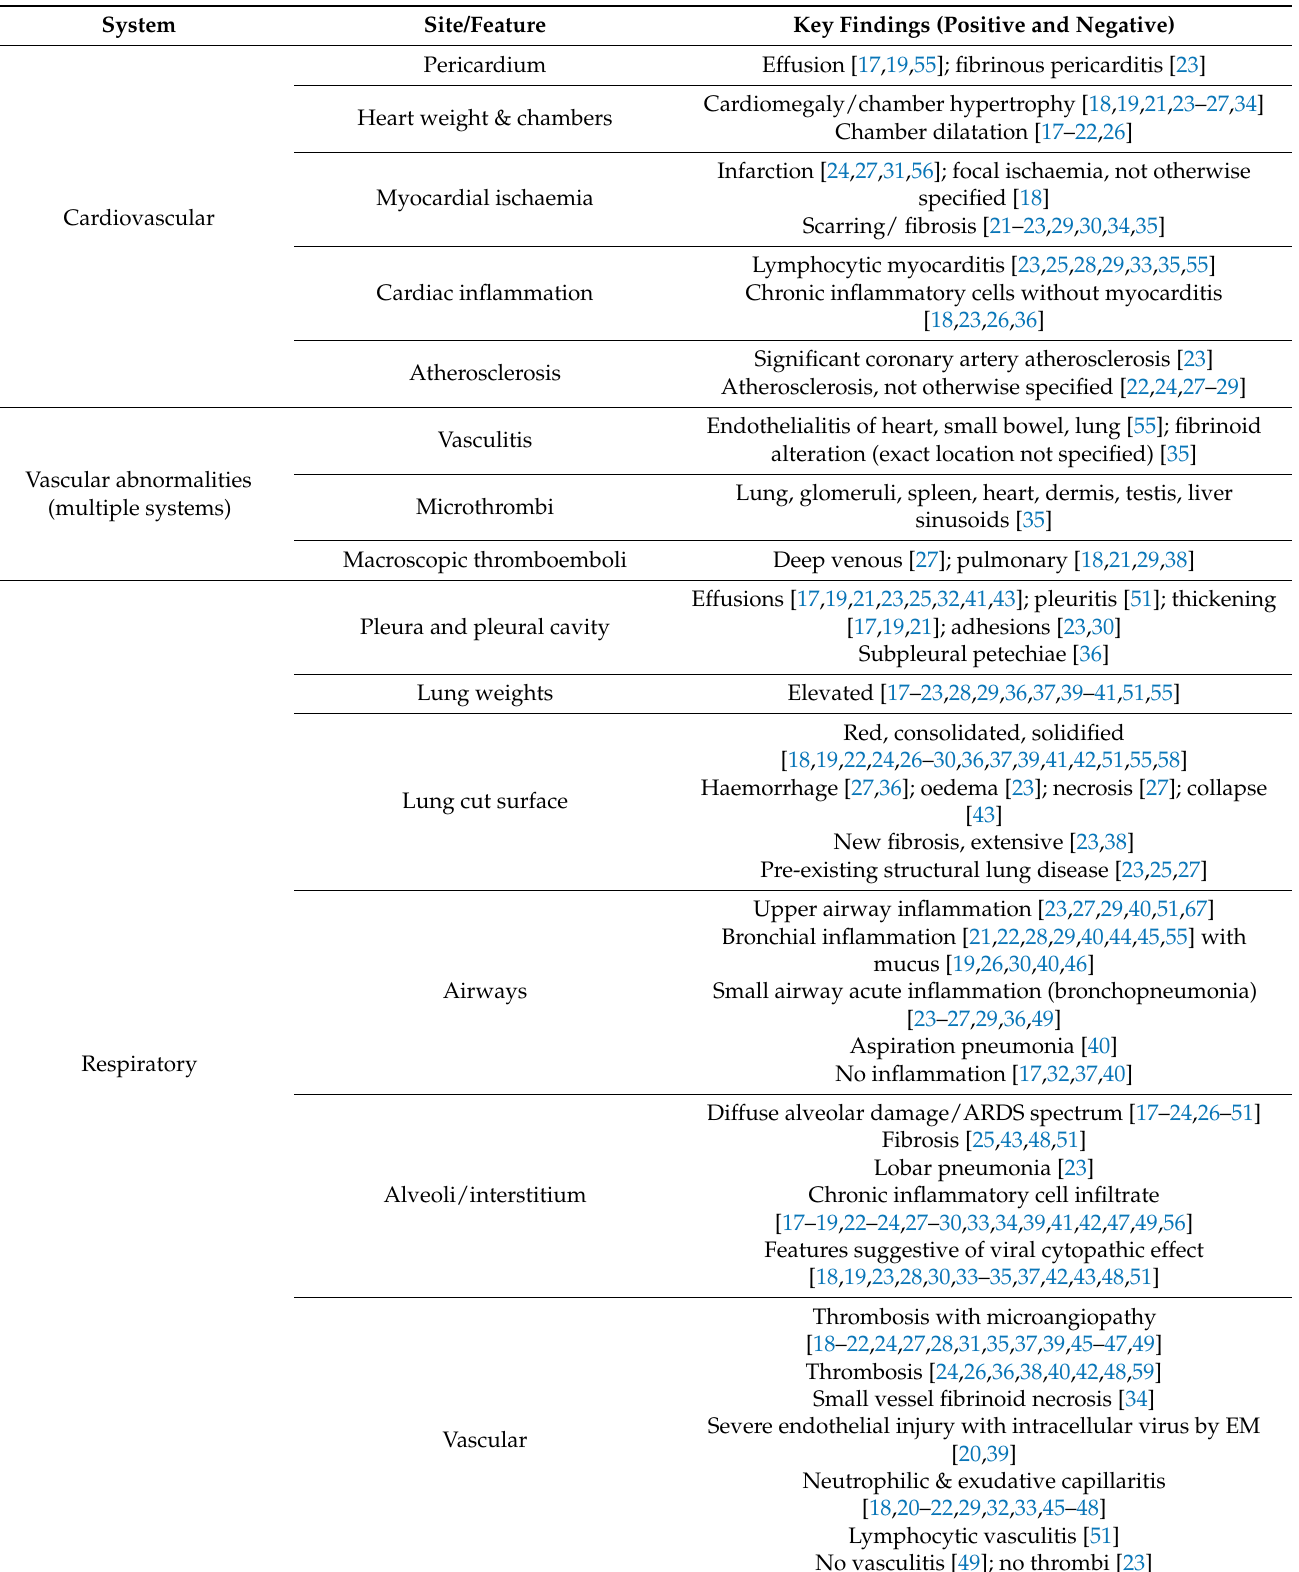
Table 2. Post-mortem pathology in COVID-19 described in published